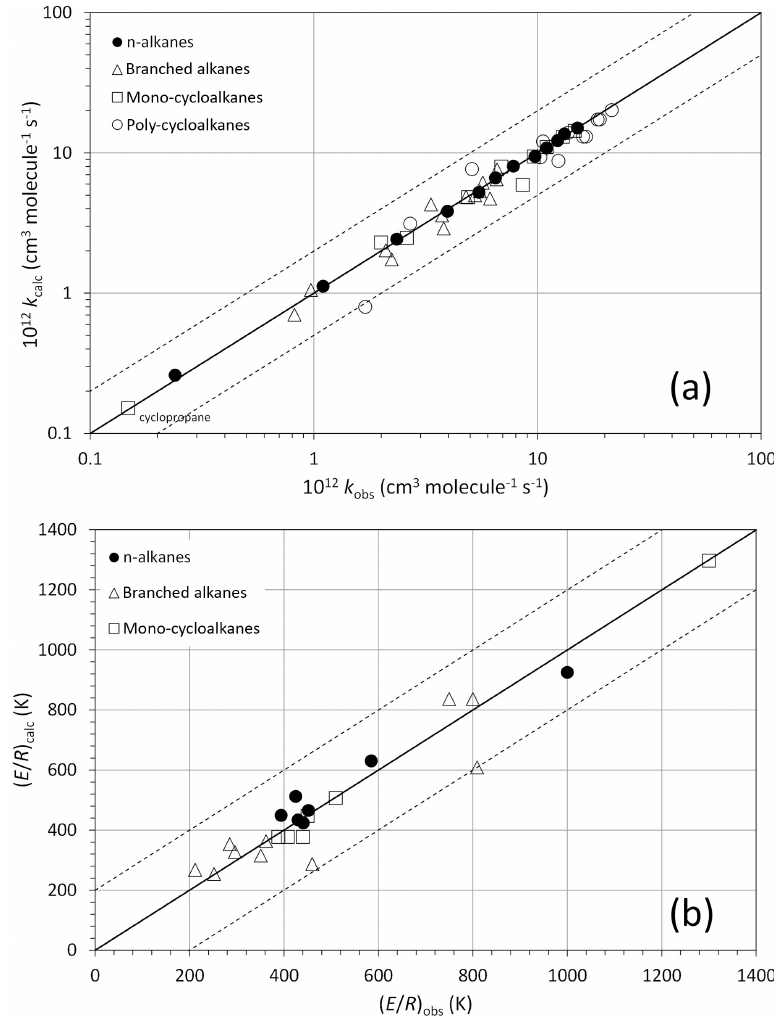
Figure 1. (a) A log–log correlation of k calc and k obs at 298K for alkanes (for presentation purposes, the value for cyclopropane has been scaled up by a factor of 2). The broken lines show the factor of 2 range (see Table S1 in the Supplement for identities of outliers). (b) A correlation of the temperature coefficients (E/R) calc and (E/R) obs for alkanes. The broken lines show the ± 200K